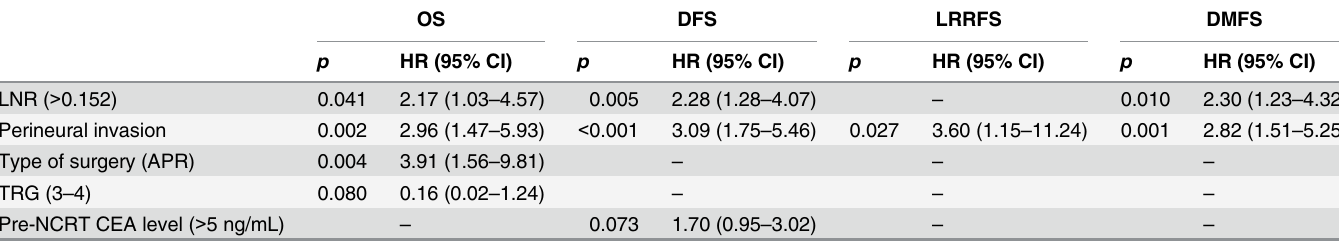
Table 3. Multivariate analysis for evaluating prognostic factors influencing outcomes.